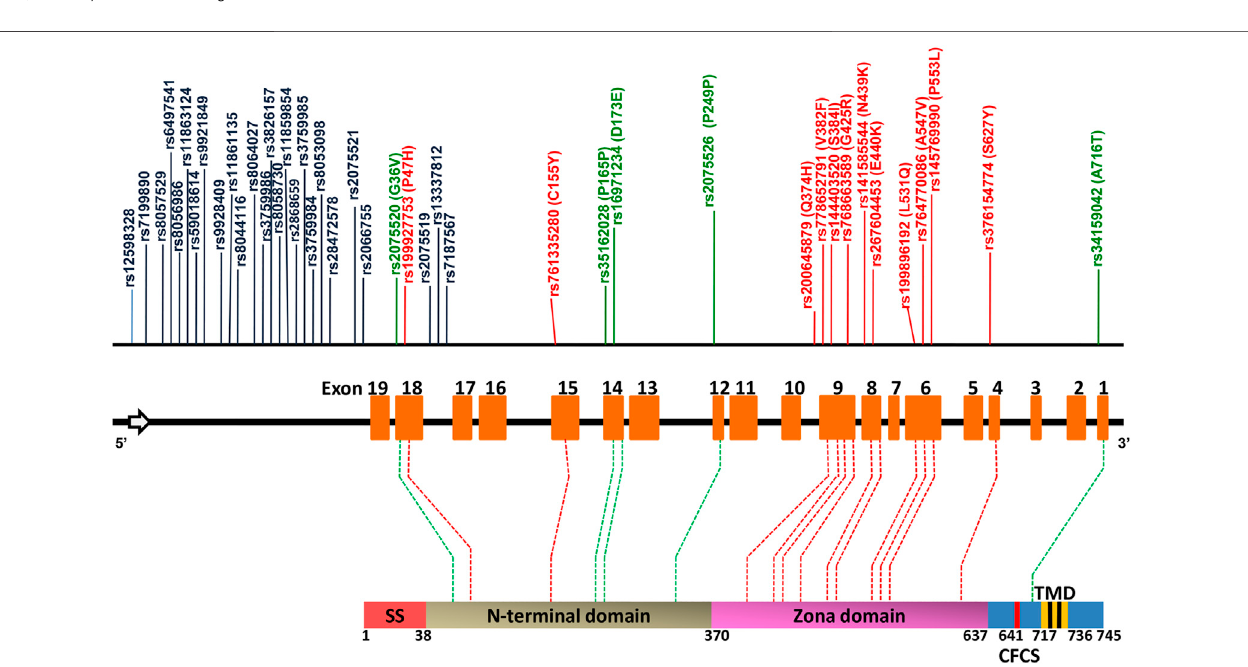
TFBS, Transcription factor binding site.